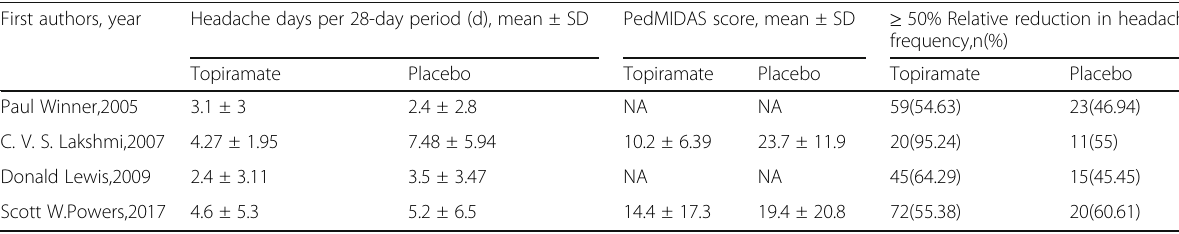
Table 2 Trial outcomes of Studies Included in the